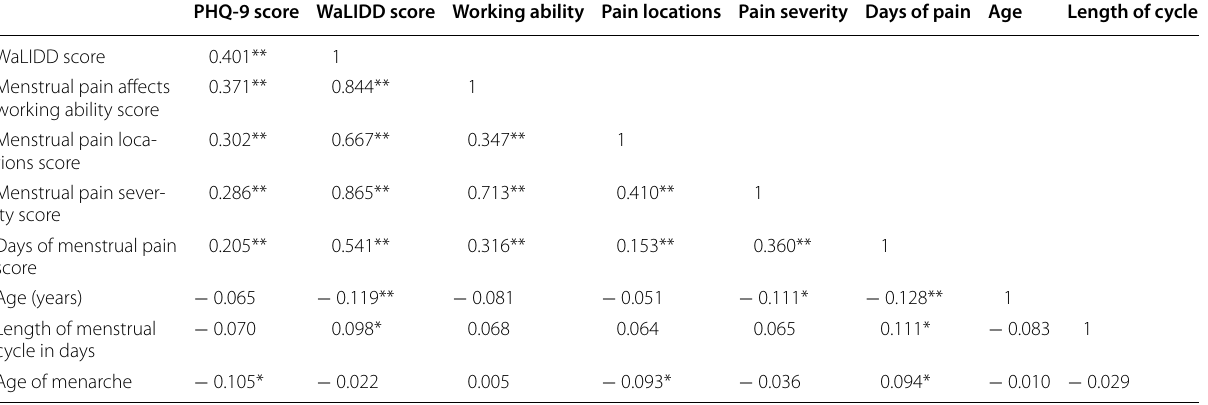
**Correlation is significant at the 0.01 level (2-tailed). *Correlation is significant at the 0.05 level (2-tailed)